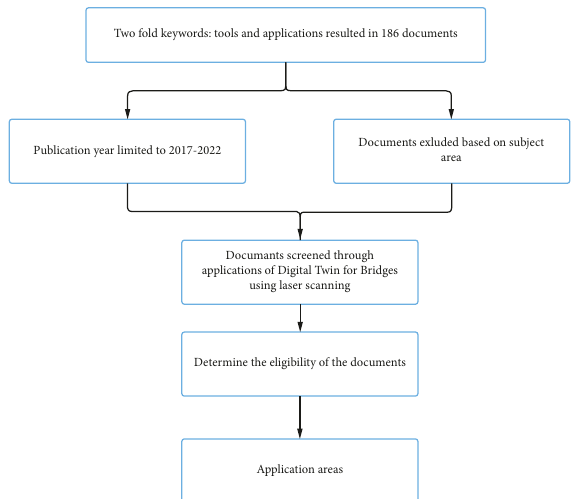
Figure 2: Scienmetric review procedure flowchart.